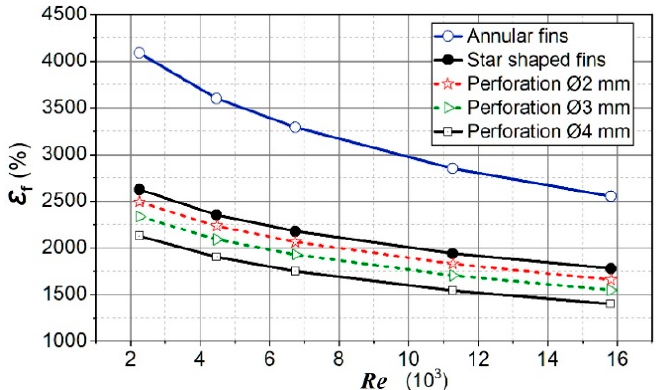
Figure 14. Fin e ff ectiveness for analyzed Figure 14. Fin effectiveness for analyzed cases.